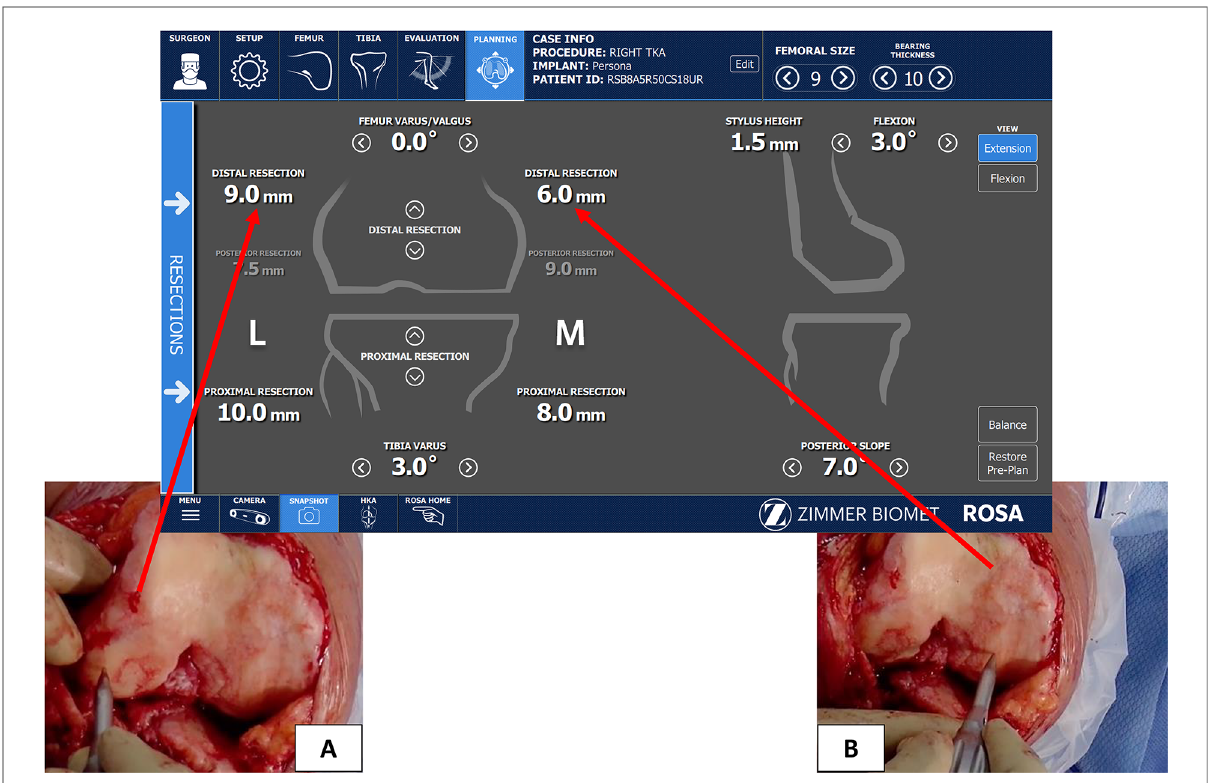
deducted the bone loss from the